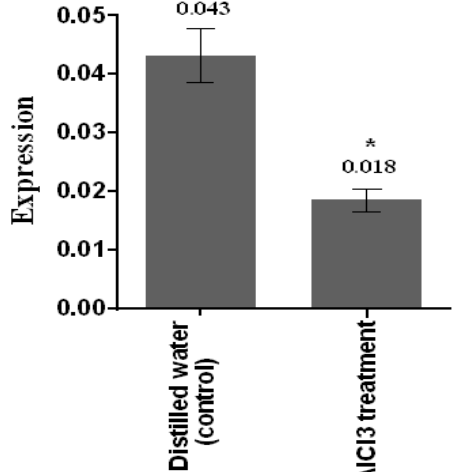
Fig. 3. Comparison of the FMR1 gene expression levels in hippocampi of the rats treated with AlCl 3 and control group: AlCl treatment significantly 3 diminished the FMR1 gene expression level. *: denotes a significant difference p ≤